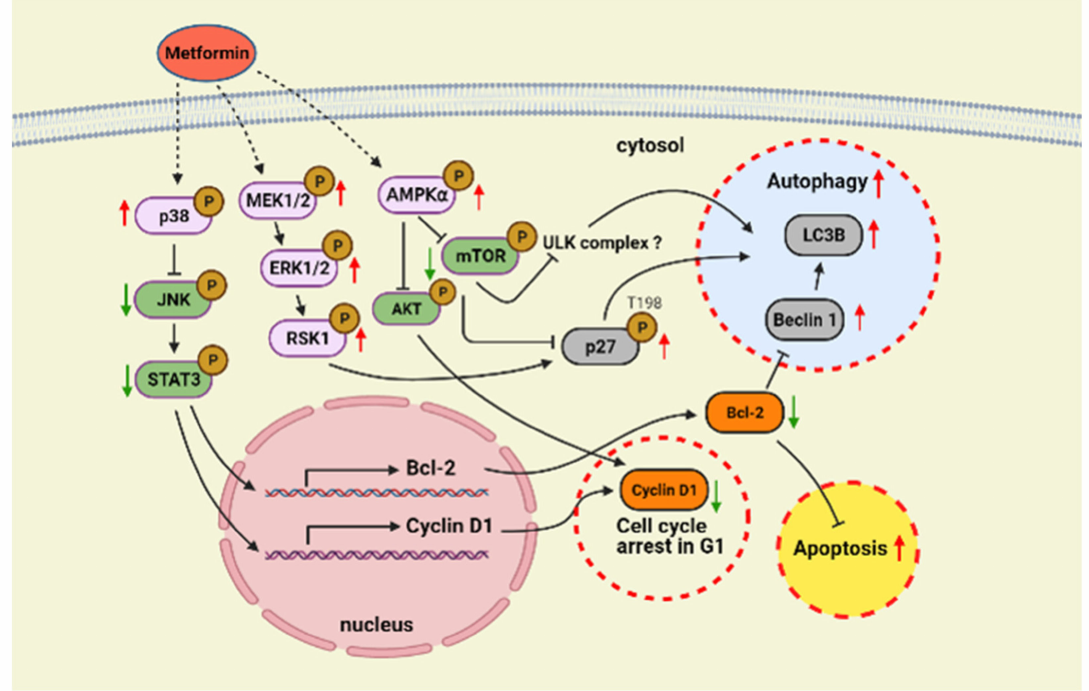
Figure 7. Schematic showing potential mechanisms of autophagy and apoptosis induction in metformin-treated hy- popharyngeal cancer cells. Metformin induces p38 activation to decrease JNK/STAT3 phosphorylation, resulting in reduction in Cyclin D1 and Bcl-2. Loss of Cyclin D1 causes cell cycle arrest at the G1 phase. Downregulation of Bcl-2 may cause the activation of both apoptosis and autophagy. In addition, metformin activates AMPK α and MEK/ERK/RSK signaling pathways to reduce mTOR and increase p27(Thr198) phosphorylation; these events may direct hypopharyngeal cancer cells toward autophagy. Upward red arrows indicate that the expression or phosphorylation of target proteins were upregulated by metformin treatment, while downward green arrows indicate the opposite